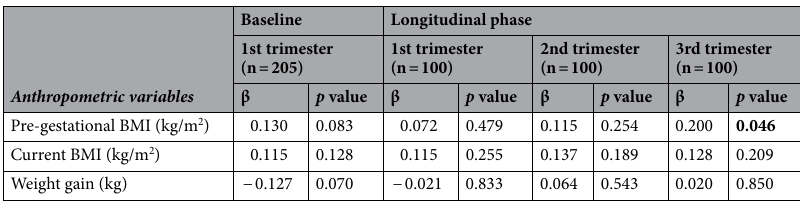
Table 2. Linear regression analysis associating social jetlag (dependent variable) with anthropometric variables (independent variable) in the baseline (n = 205) and over the trimesters in the longitudinal phase (n = 100). Linear regression analysis adjusted model for age, marital status, schooling, work (yes or no), gestational age and parity. Bold value is statistically significant at p < 0.05. BMI body mass index.